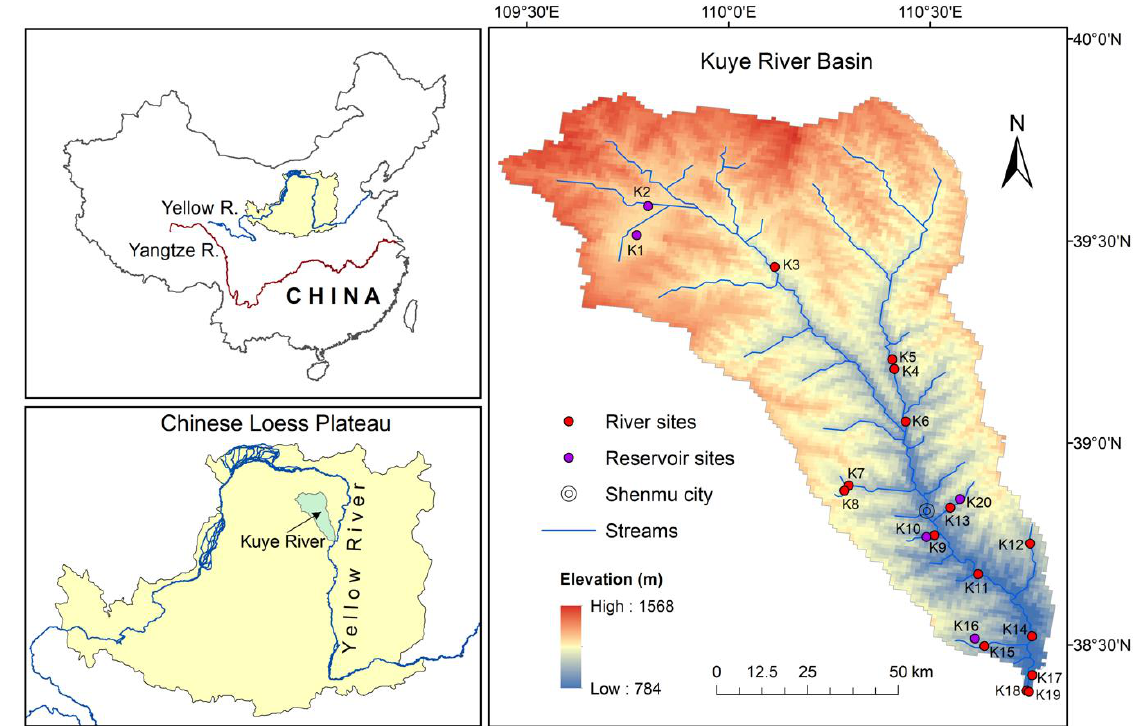
Figure 1. Location map of the Kuye River Basin (KRB) with the sampling